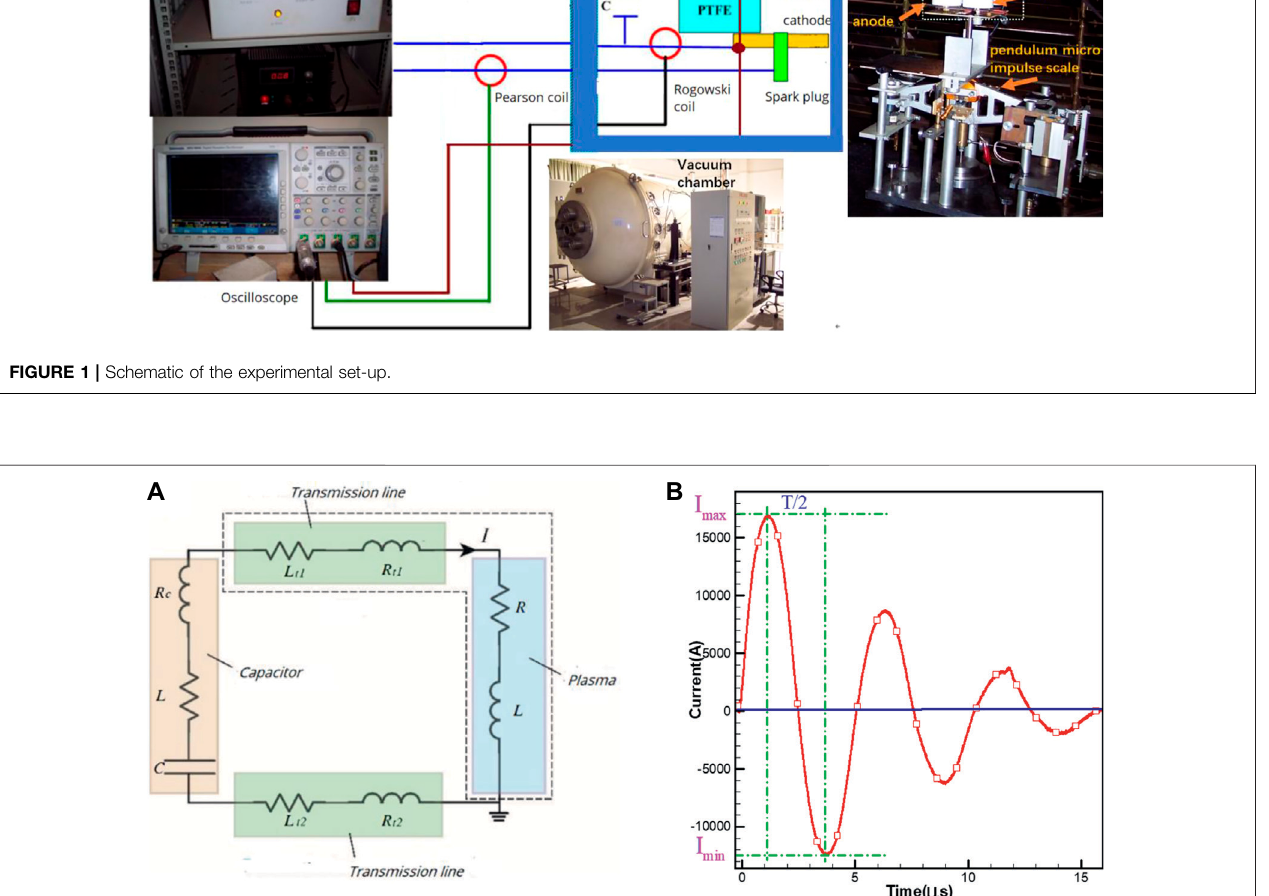
FIGURE 2 | (A) Equivalent circuit diagram and (B) typical discharge current waveform of